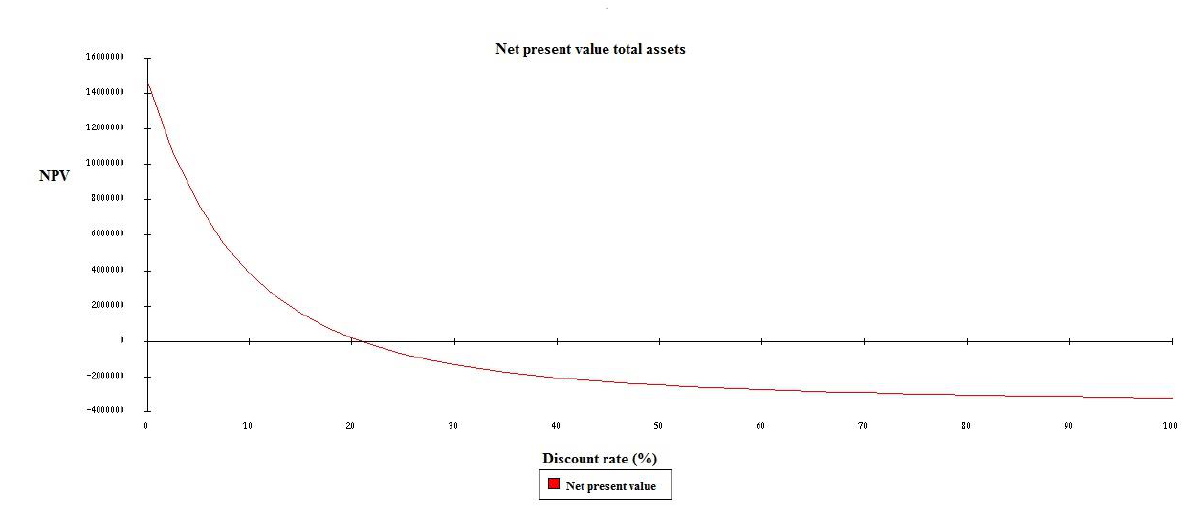
Sensitivity Analysis